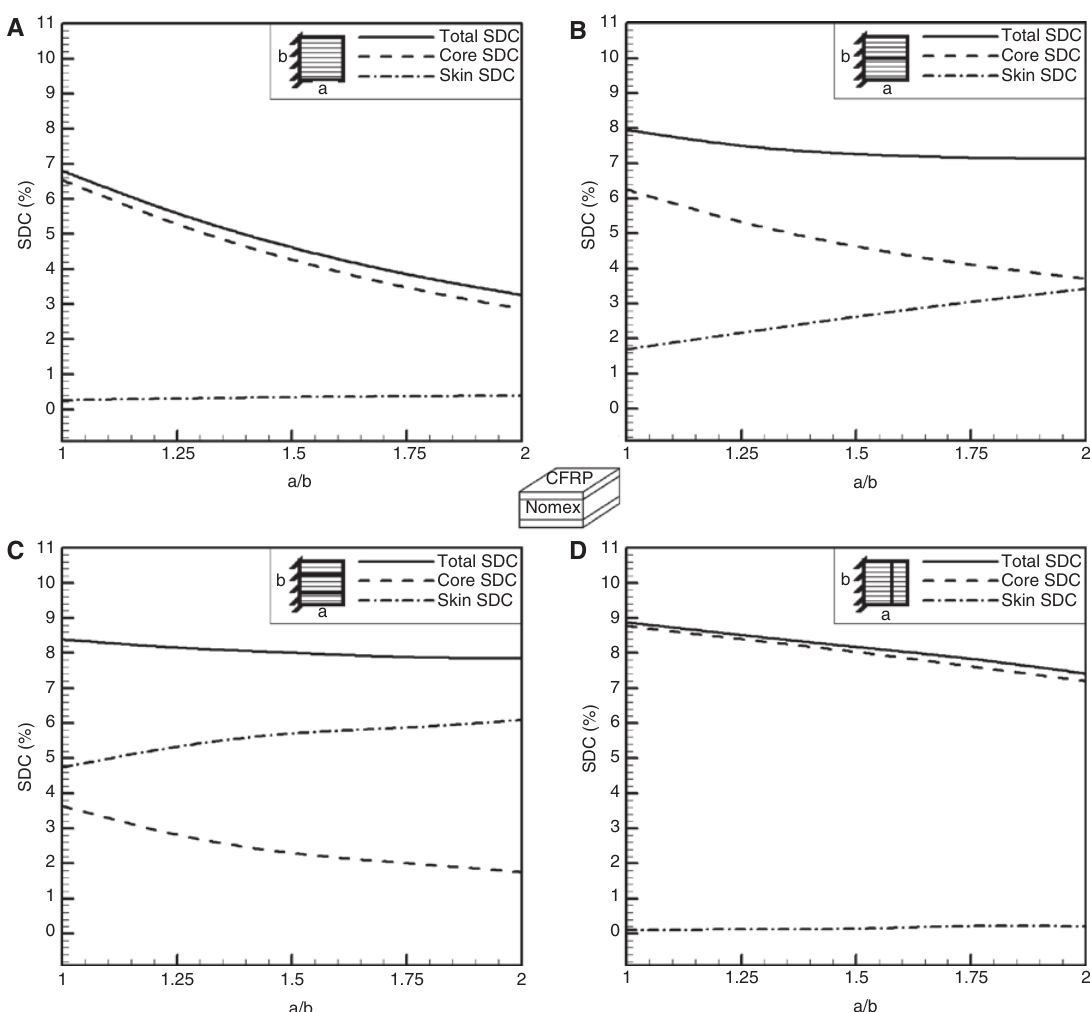
Figure 4: Damping of a cantilevered, all-zero CFRP/Nomex honeycomb sandwich panel versus aspect ratio, in various modes. (A) First mode, (B) second mode, (C) third mode, (D) fourth